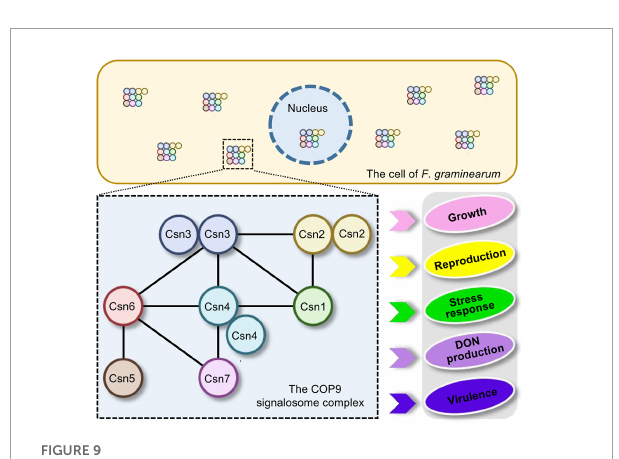
FIGURE9 Proposed model for the regulation of fungal development and virulence by the Csn complex in F. graminearum . The dashed box represents the Csn complex and its interactions. The black lines within the box indicate the direct interactions between the Csn subunits. The Csn complex localizes to the nucleus and cytoplasm and the loss of the Csn complex leads to defects in hyphal growth, asexual and sexual reproduction, stress response, DON production and